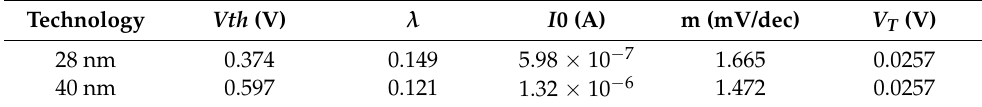
Table 15. Coefficients under different technologies for NMOS.